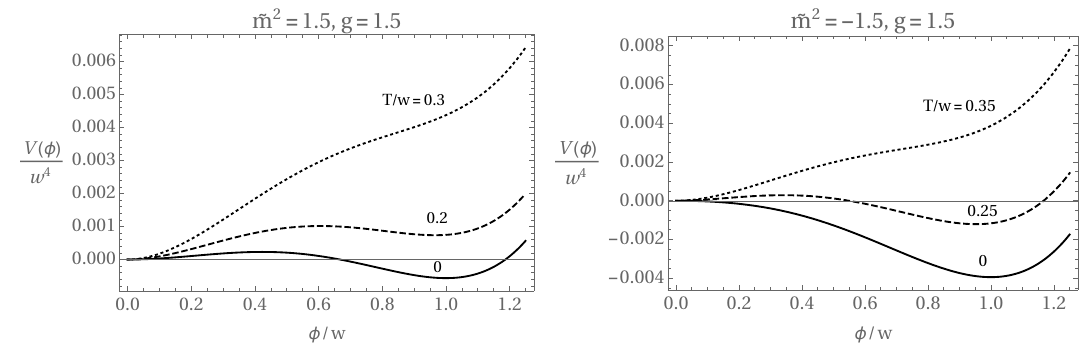
Figure 1 . The scalar potential V ( (cid:30) ) of the hidden sector that we consider, at di(cid:11)erent points in parameter space (left and right), at zero temperature (solid) and increasing temperature (dashed, dotted). The model plotted in the left panel has a barrier between the two vacua that remains at zero temperature, and the barrier disappears at zero temperature in the model in the right